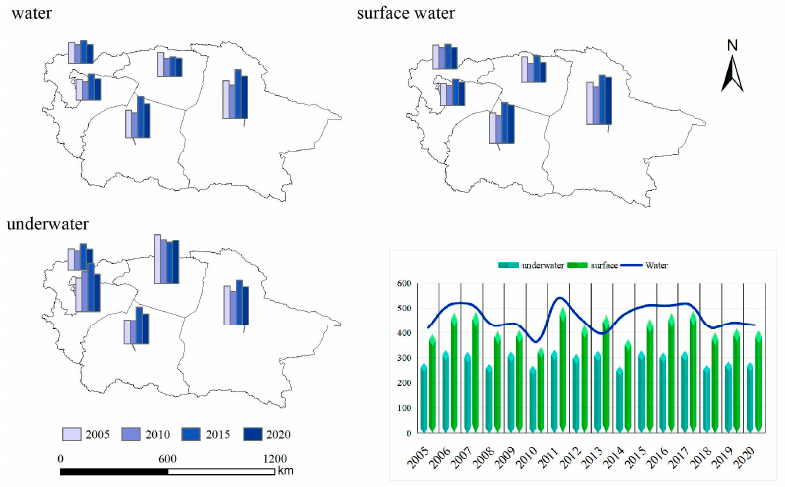
Figure 8. Spatial distribution of water resources in the Tarim River Basin.